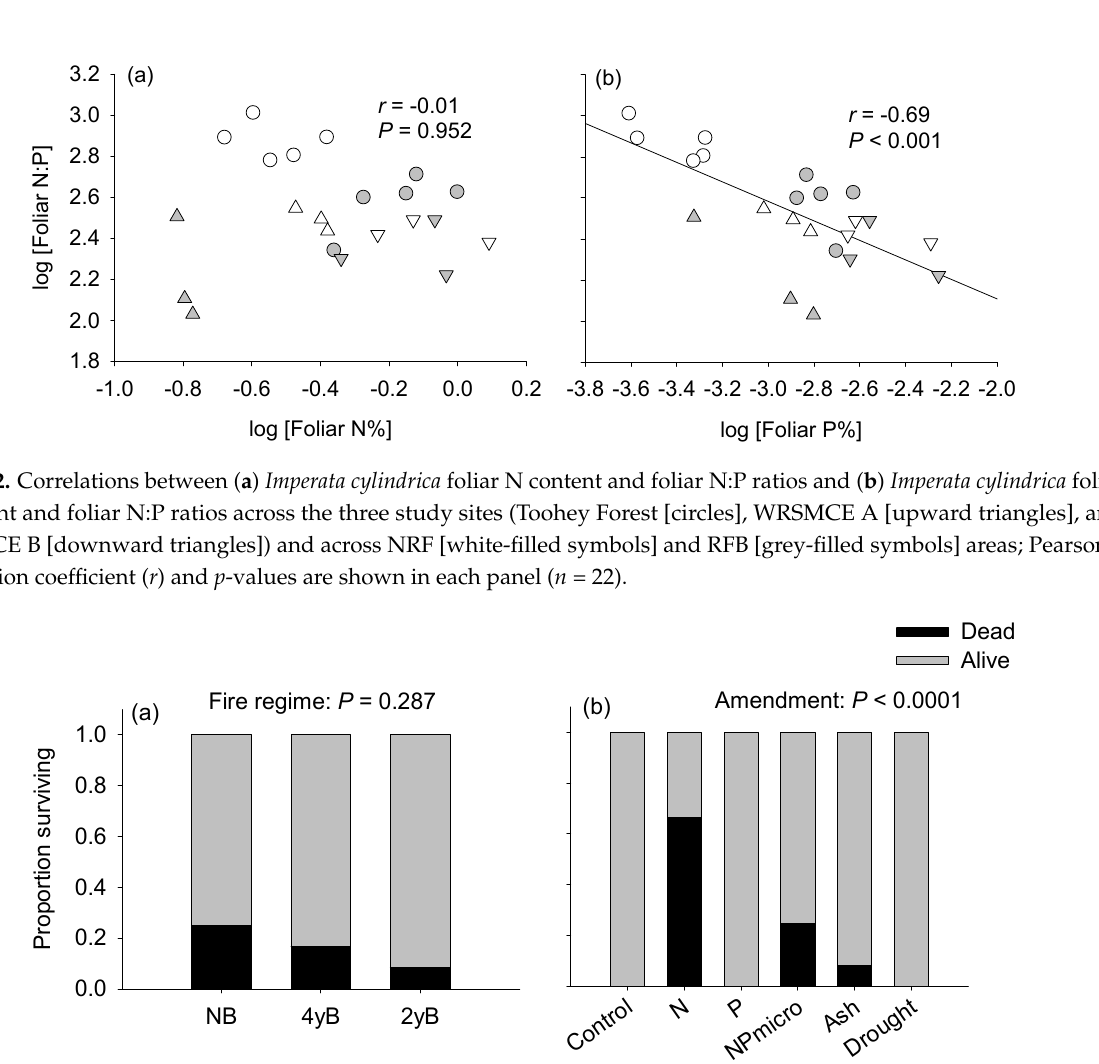
Figure 1. Box-and-whisker plots showing ( a ) nitrogen (N) content, ( b ) phosphorus (P) content, ( c ) carbon (N):N ratios, ( d ) C:P ratios, and ( e ) N:P ratios of leaves of mature Imperata cylindrica growing in areas of eucalypt forests that have either had no recent fires (NRF) or that have been exposed to recent and/or frequent burning (RFB). The NRF and RFB areas were compared using Student’s paired t -tests ( n = 11 for all variables; p -values are shown in each panel). In each box, the median is shown by the solid line and the mean is shown by the dotted line.